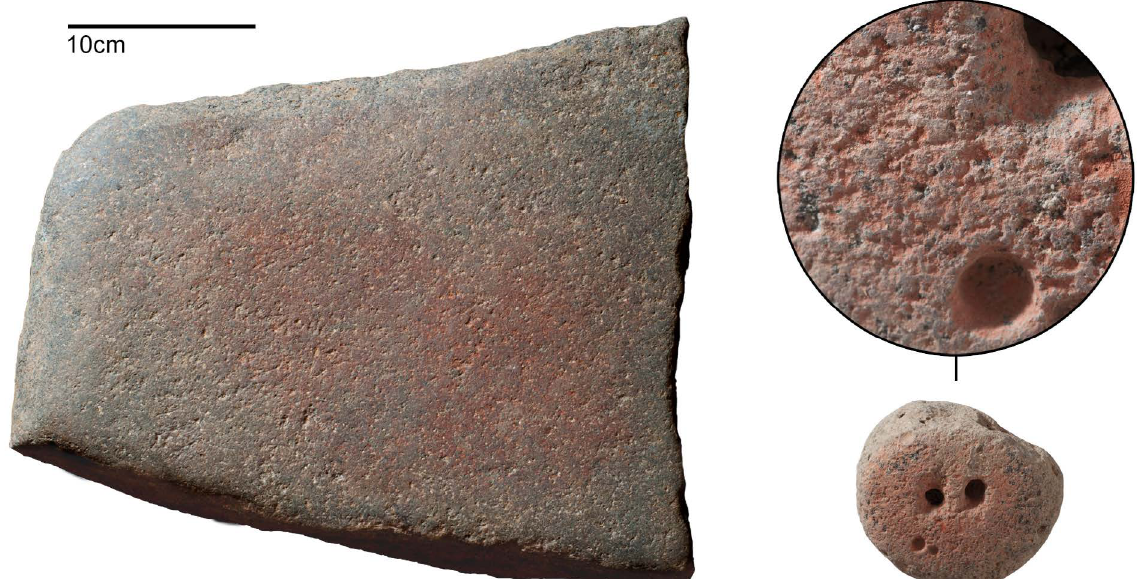
Figure 14: A grinding slab (left) and handstone (right) stained by ochre, presumably the result of pigment